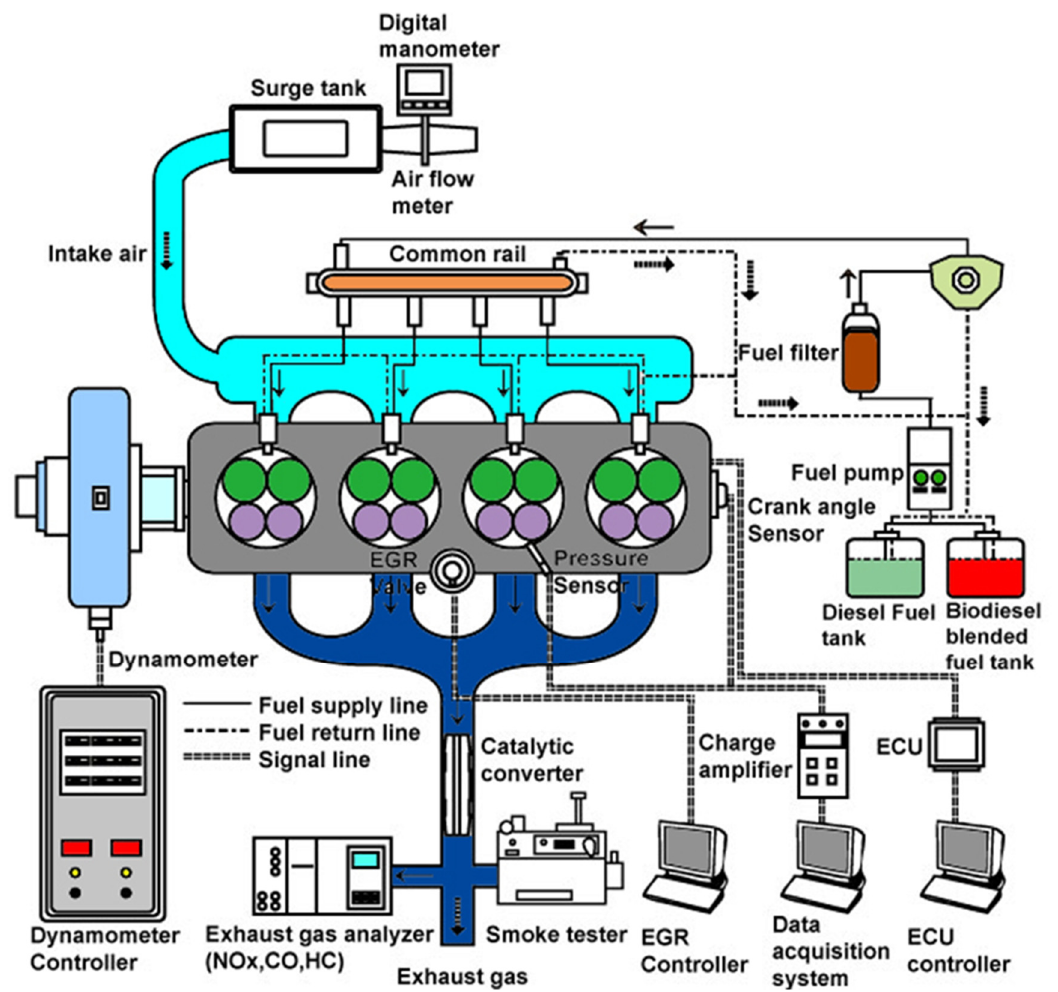
Figure 1. Schematic diagram of the experimental apparatus. HC: